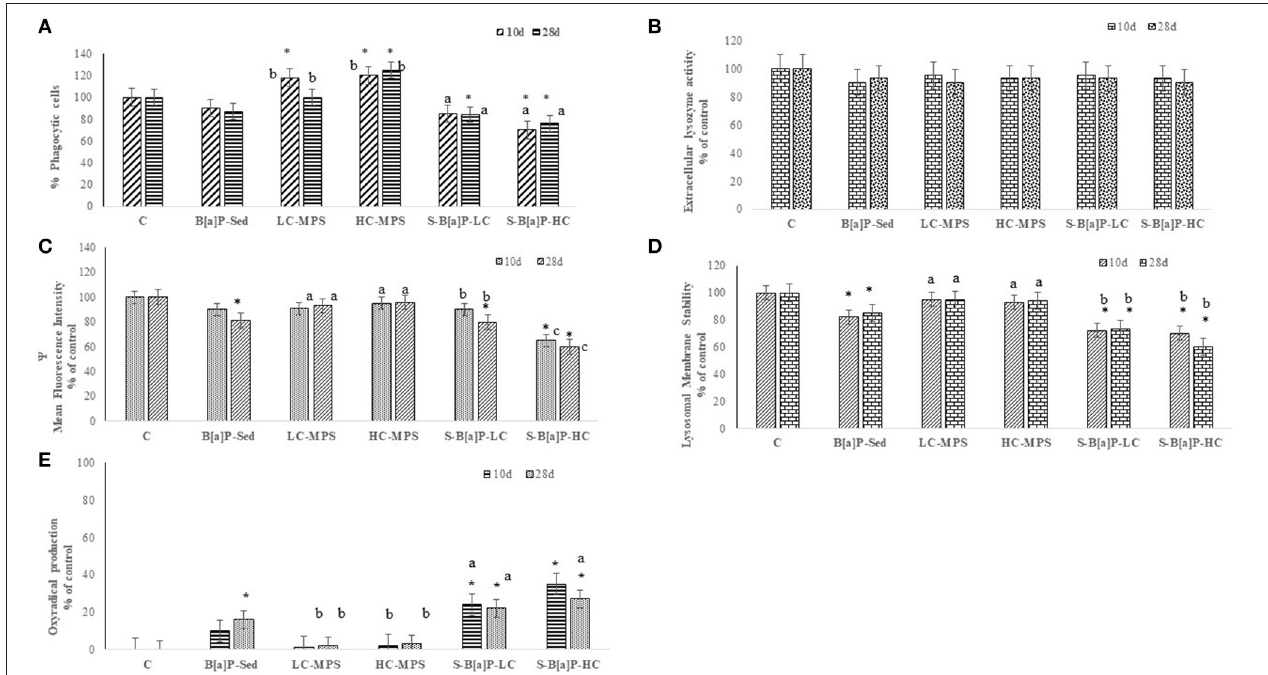
FIGURE 1 | Biological responses in coelomocytes of H. diversicolor exposed to uncontaminated sediments (C), D sediments spiked with 1mg/L B[a]P (S-B[a]P), sediments spiked with 200 and 2000 particles/kg virgin PVC (LC-MPS, HC-MPS) and sediments with B[a]P spiked microplastic particles (B[a]P-LC: 200 particles/kg.; B[a]P-HC: 2000 particles/kg). (A) Response of the phagocytic activity, (B) Extracellular lysozyme release, (C) mitochondrial activity, (D) Lysosomal membrane stability, (E) Oxyradical production. * p < 0.05. Data are expressed as mean values ± standard deviation, n = 6. Different letters indicate significant differences between groups of means ( post-hoc